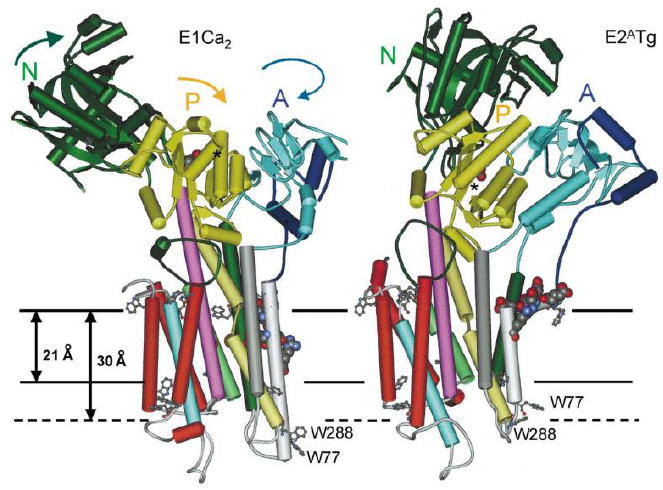
Figure 6. Comparison of the structures of the Sarco / Endoplasmic Ca 2 + ATPase (SERCA) in its Ca 2 + -bound (E1Ca 2 ) and Ca 2 + -free, thapsigargin-bound (E2 A Tg) forms. Thapsigargin binds in a pocket between the helices M3 (dark grey), M5 (lilac), and M7 (red); therefore, preventing the conformational change to the active E1 state, in which the pocket is smaller. Reproduced from [258].